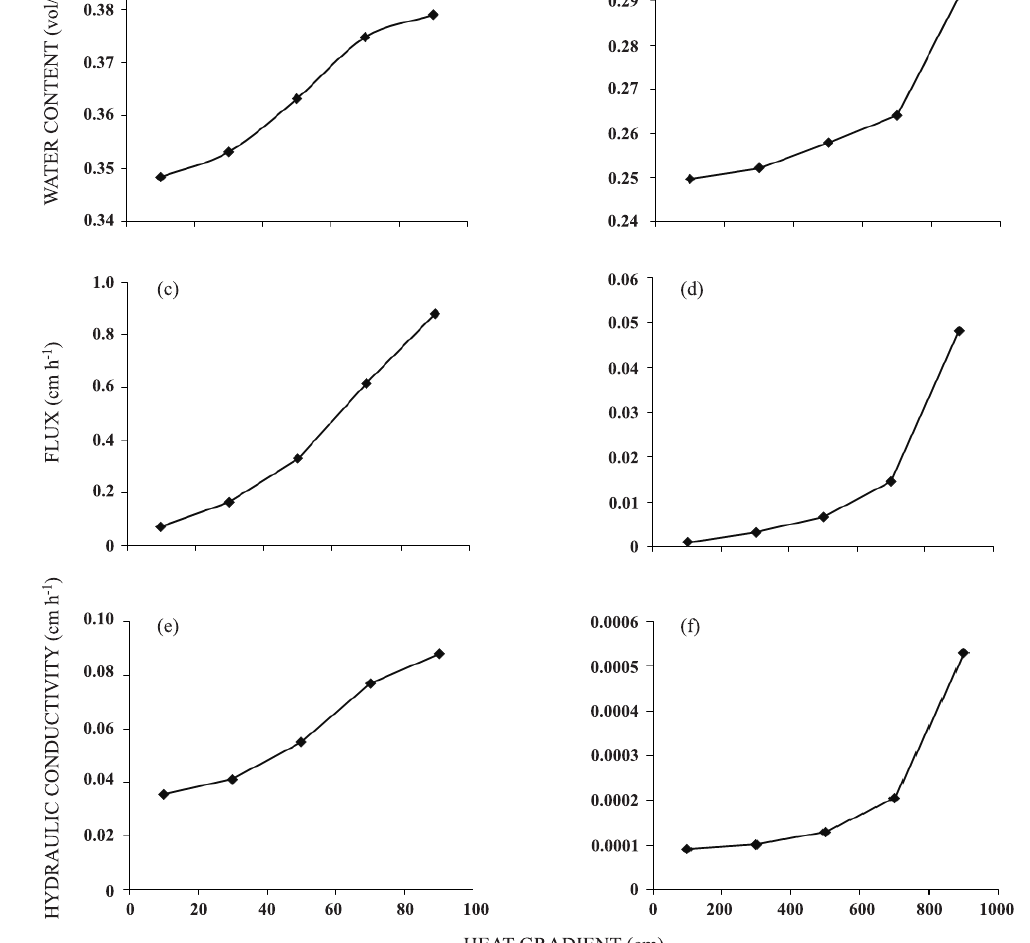
Figure 3. Water content (a and b), hydraulic flux (c and d) and hydraulic conductivity (e and f) vs. head difference (upper BC – lower BC) in the pure phase Clay Loam system.